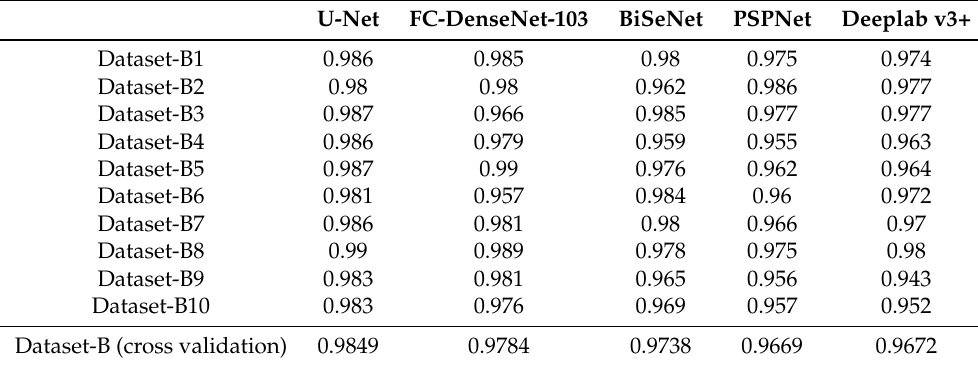
Table 12. Dice score (F1) measured for every algorithm on Dataset-B (cross-validation).